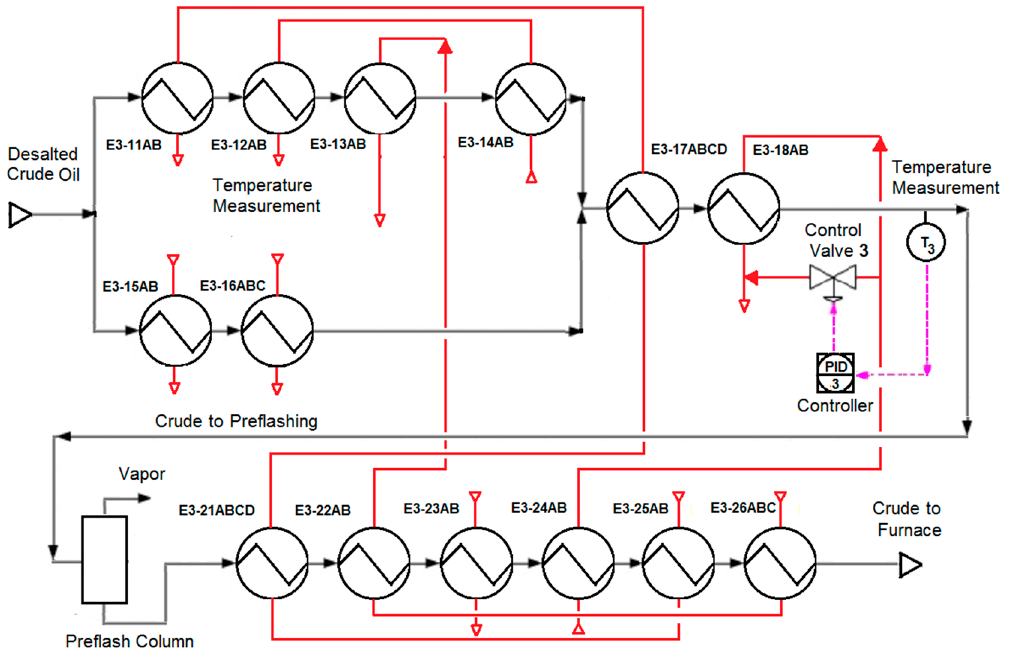
Figure 3. Scheme of the HEN with the PID control loop number 3.